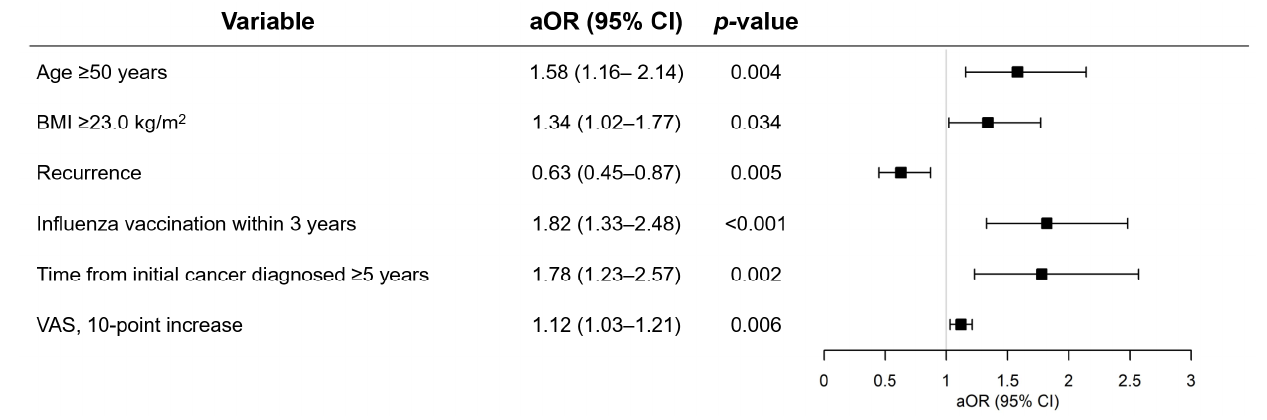
Figure 3. Results of multivariable logistic regression analysis for COVID-19 vaccination acceptance.